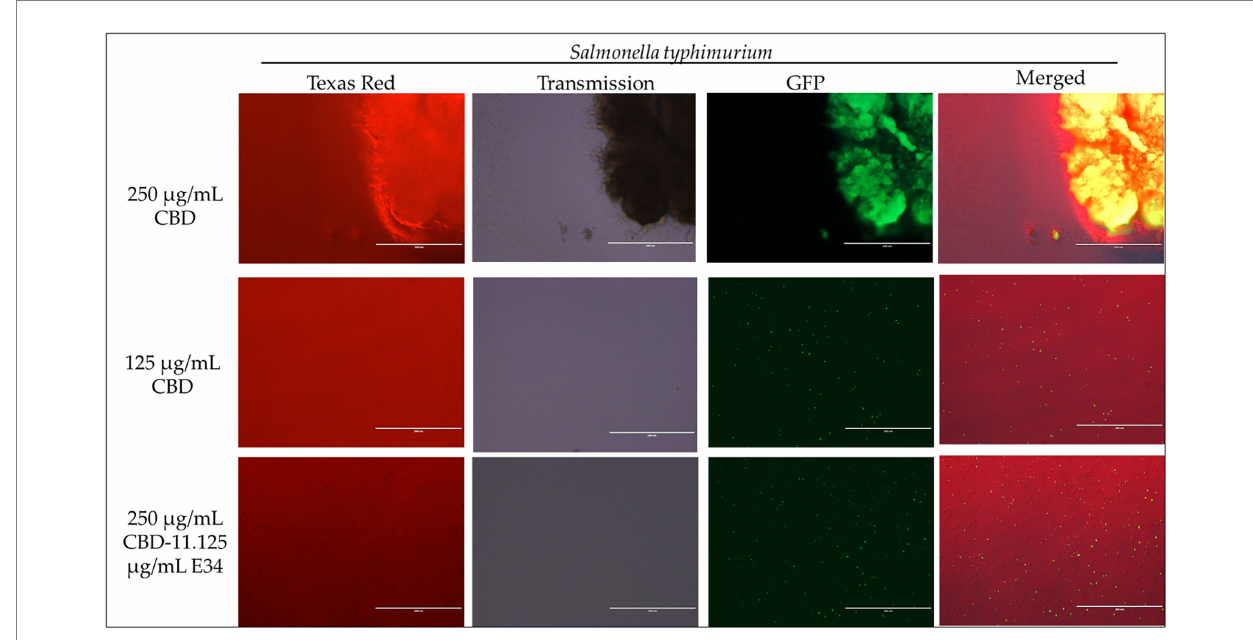
FIGURE 5 Immunofluorescence analysis of S . Typhimurium (ST) at high concentrations of CBD extract (250 μ g/ml, 125 μ g/ml, and 250 μ g/ml + 11.125 μ g/ml E34 TSP) treatment. As shown in all panels, treatment at higher concentrations killed the S . Typhimurium. However, bacteria seemed to cluster together into biofilms enhancing their ability to survive (See top